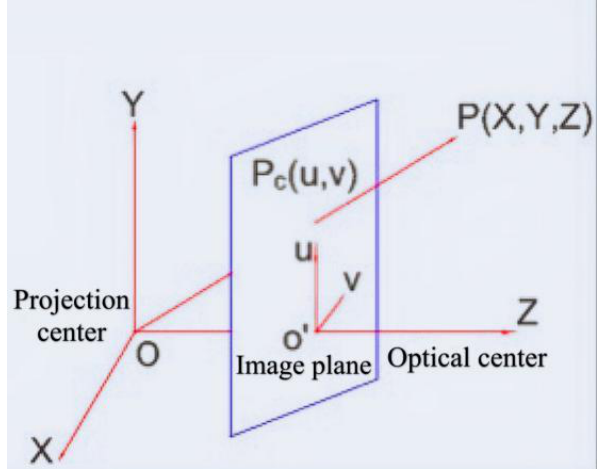
Figure 2. Pinhole imaging model .